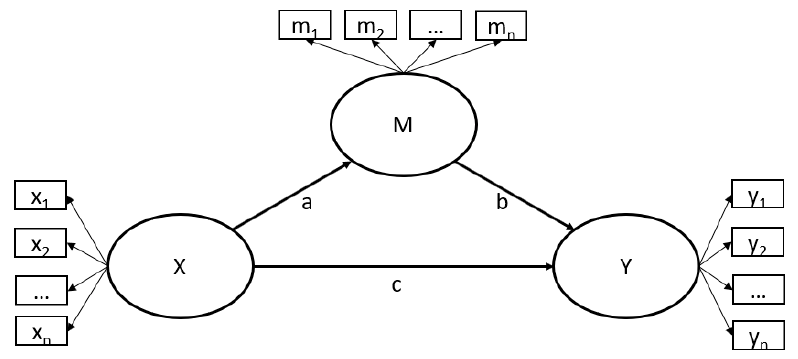
Figure 1. Research framework. Source: Created by the author, based on [13,47].